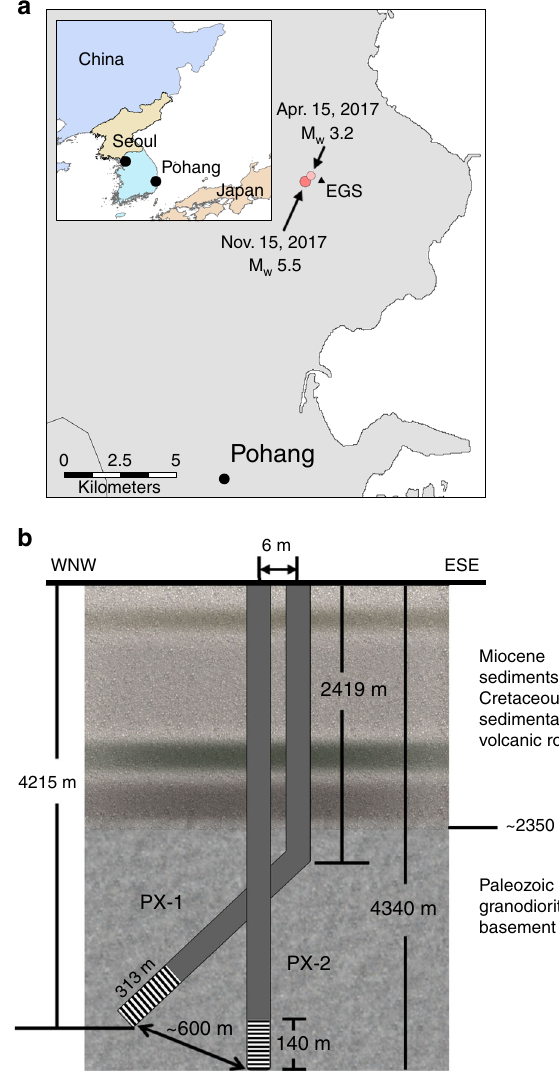
Fig. 1 Pohang enhanced geothermal system. a Location of the Pohang EGS site, epicenters of the two largest events, April 15, 2017 M w 3.2 and November 15, 2017 M w 5.5. Inset shows the location of Pohang in South Korea. Country outlines from www.gadm.org. b Schematic diagram of two geothermal exploration wells, PX-1 and PX-2, and generalized lithology of the area 21